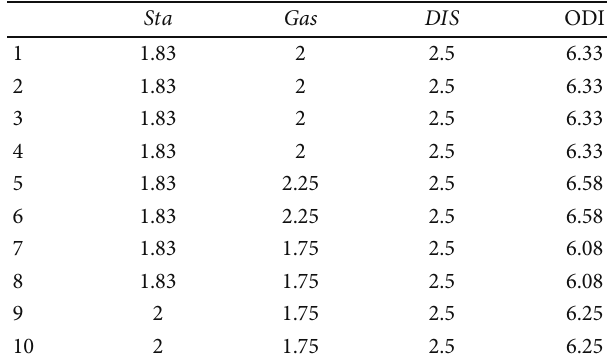
Table 5: Coal and gas outburst risk